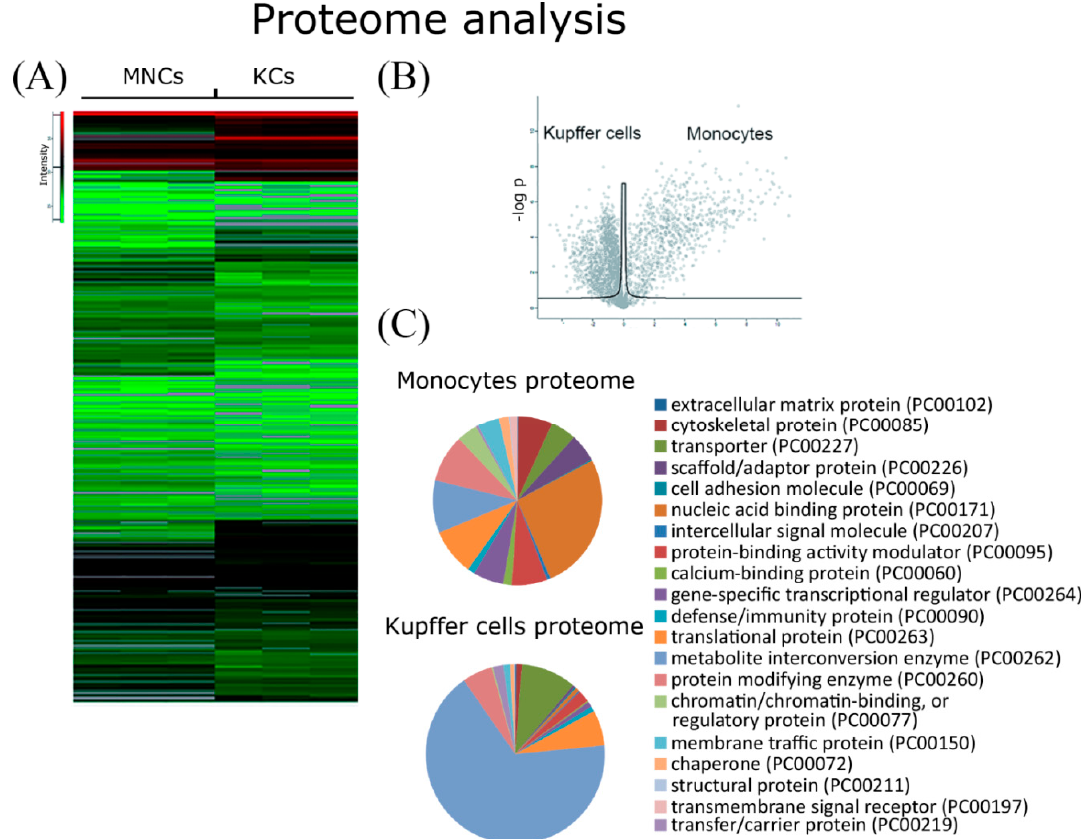
Figure 4. Proteome analysis for monocytes and Kupffer cells. Heatmaps presenting differentially expressed proteins ( A ). A scatter plot showing the difference in the expression of proteins associated with monocytes and Kupffer cells ( B ). Pie charts of the functional categories of the proteome for monocytes and Kupffer cells ( C ). Pie charts of the protein class categories of the proteome for monocytes and Kupffer cells are listed in Figure S4.